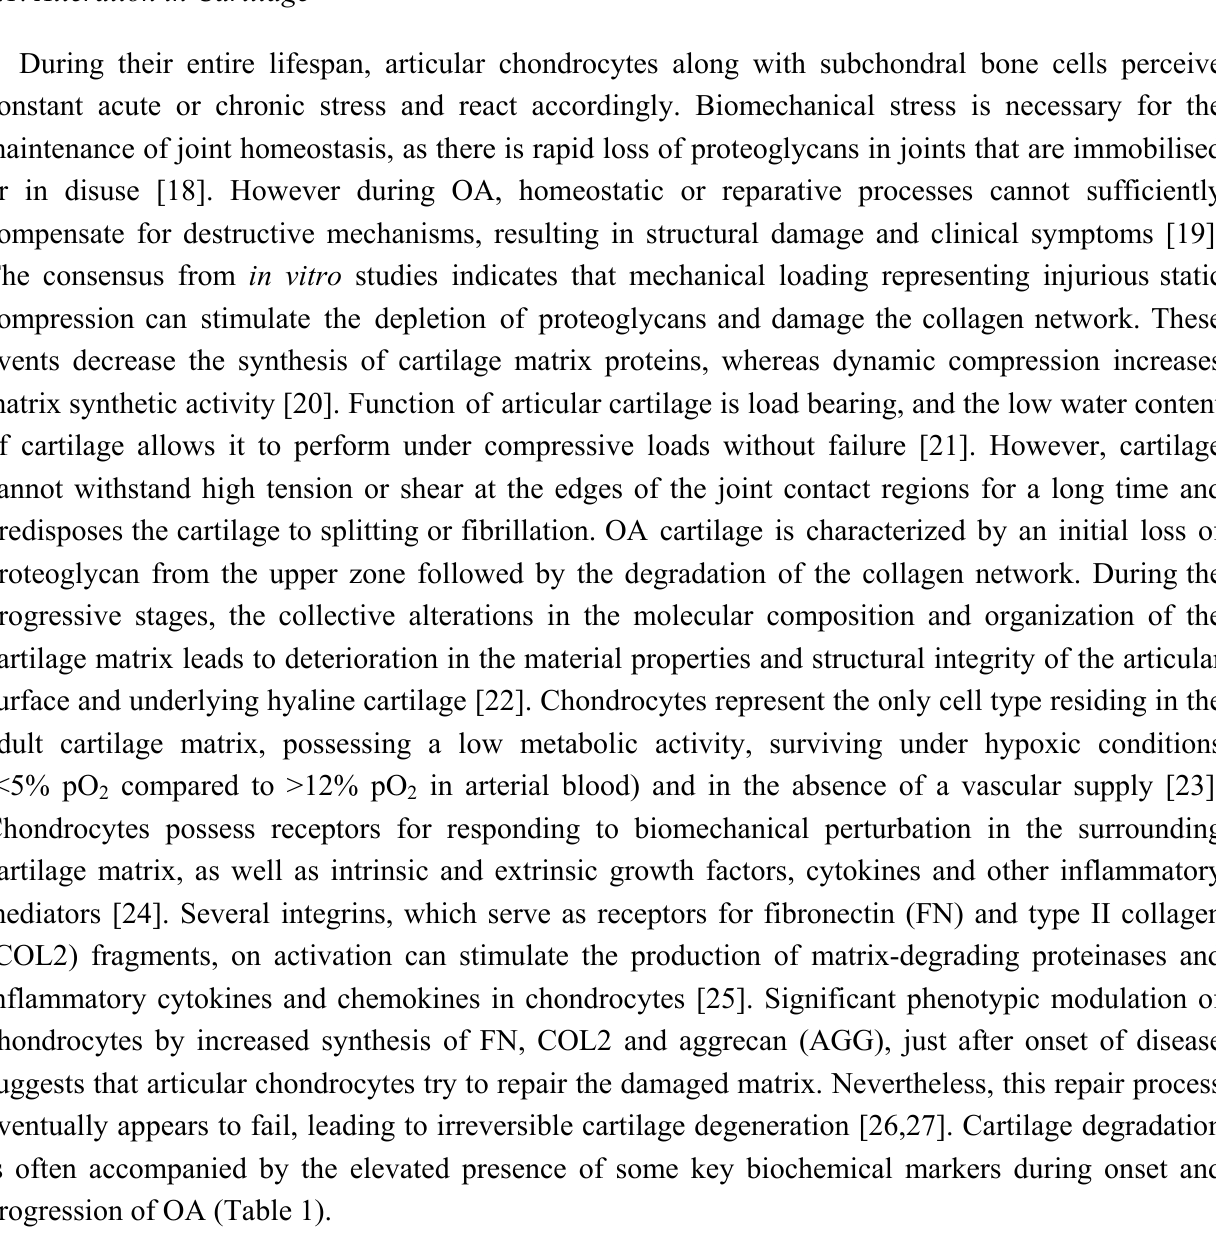
Table 1. Biomarkers of cartilage and subchondral bone during onset and progression of Osteoarthritis (OA).